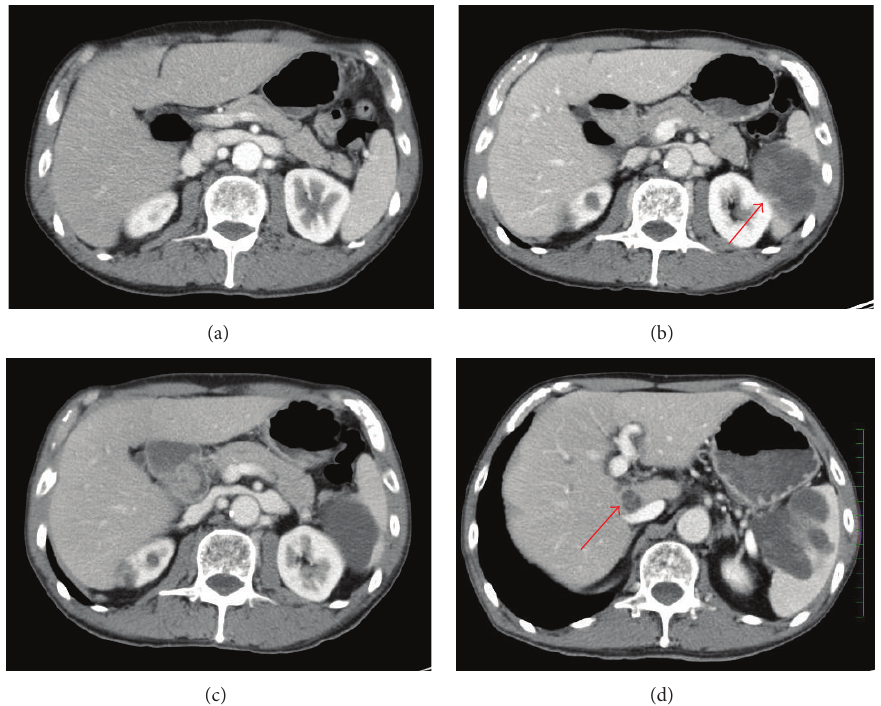
Figure2:(a)TherearenoabnormalfindingsinabdominalCTscanbeforesurgery.(b)AbdominalCTscanwithcontrast6weeksaftersurgery shows a mass with inhomogeneous opacity in the spleen (arrow). (c) Abdominal CT scan with contrast after the 3 courses of chemotherapy by carboplatin and paclitaxel plus bevacizumab. The tumor size is reduced and its inhomogeneous opacity changed to homogeneous opacity. (d) Abdominal CT scan with contrast after the 4 courses of chemotherapy shows a new metastasis to the liver and enlarged metastatic tumor in the spleen (arrow).